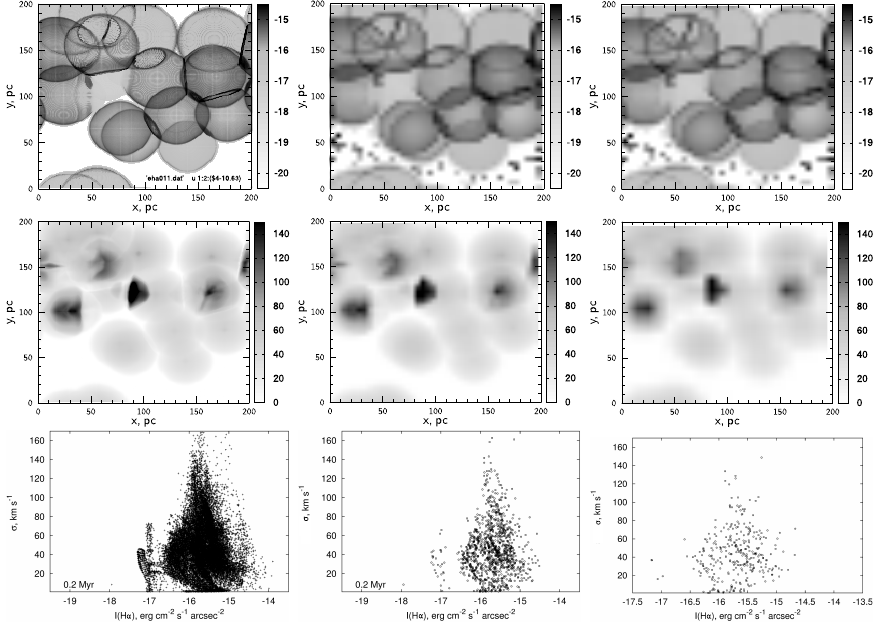
Fig. 4. H (cid:11) intensity I H (cid:11) (in erg cm (cid:0) 2 s (cid:0) 1 arcsec (cid:0) 2 ) (the top row) and velocity disper- sion (in km s (cid:0) 1 ) (the middle row) maps and the I H (cid:11) { (cid:27) diagram (the bottom row) for the SN rate 1 : 25 (cid:2) 10 (cid:0) 11 pc (cid:0) 3 Myr (cid:0) 1 at t = 0 : 2 Myr. The left-column panels show the numerical data without degrading the resolution. The middle-column panels show the smoothed and binned data for h = 2 : 5 pc and N = 5 pc and the right-column panels, the smoothed and binned data for h = 5 pc and N = 10 pc.